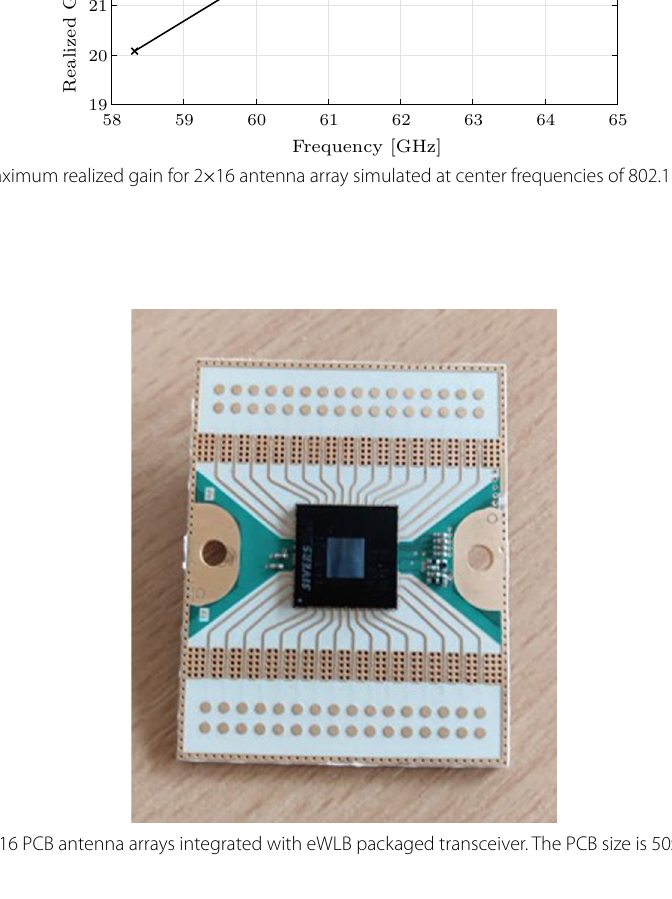
patch array. The circular patches on top metallic layer of the sub-array are electromag- netically coupled with the rectangular patches which are series fed through a microstrip line. The detailed design is presented in Fig. 1d of reference [10]. The maximum realized gain of the antenna array is presented in Fig. 11 for the center frequencies of 802.11ad channels 1–4. The results show more than 20 dBi realized gain for the whole band. × 16 TX and RX arrays separately as shown The eWLB packaged transceiver feeds the 2 in Fig. 12. The sub-arrays in the center have shorter microstrip lines than the ones on the edges, for which the phase can be compensated in the transceiver beam-book. Each trans- ceiver path provides a single column of the antenna array with specific amplitude and phase, and the main beam of the antenna array can be steered in the H-plane by provid- ing progressively increasing or decreasing phases. When main beam of the array is steered toward maximum angle θ , the grating lobes can start appearing in the radiation pattern. Equation 2 presents the criteria needed to avoid these grating lobes in terms of spacing d between adjacent sub-arrays [18].